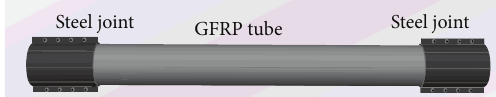
Figure 2: The integrity of the GFRP tube and steel